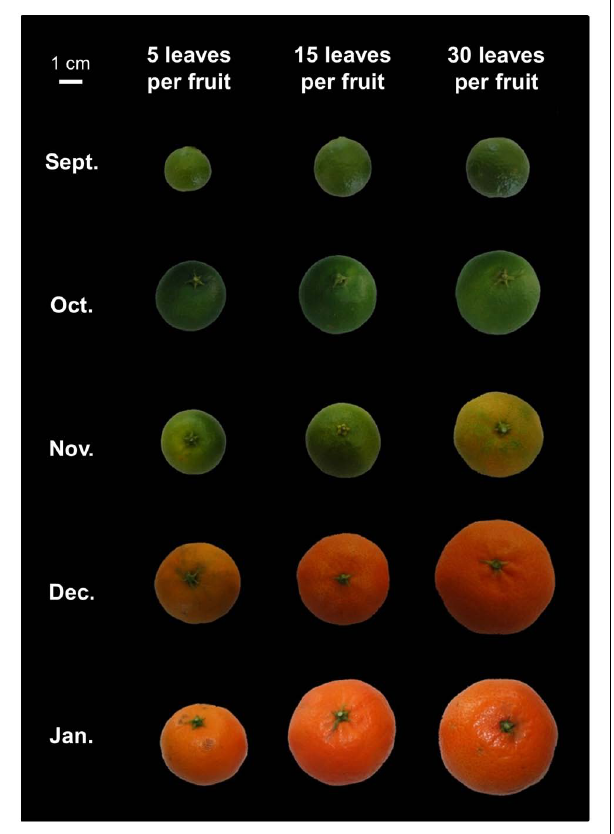
FIGURE 5 | Photographs of representative clementine fruits from fruiting branches bearing 5, 15, or 30 leaves. The pictures illustrate the effects of carbon availability on fruit growth and maturity. A low carbon supply (five leaves per fruit) reduced fruit diameter and induced a delay in fruit